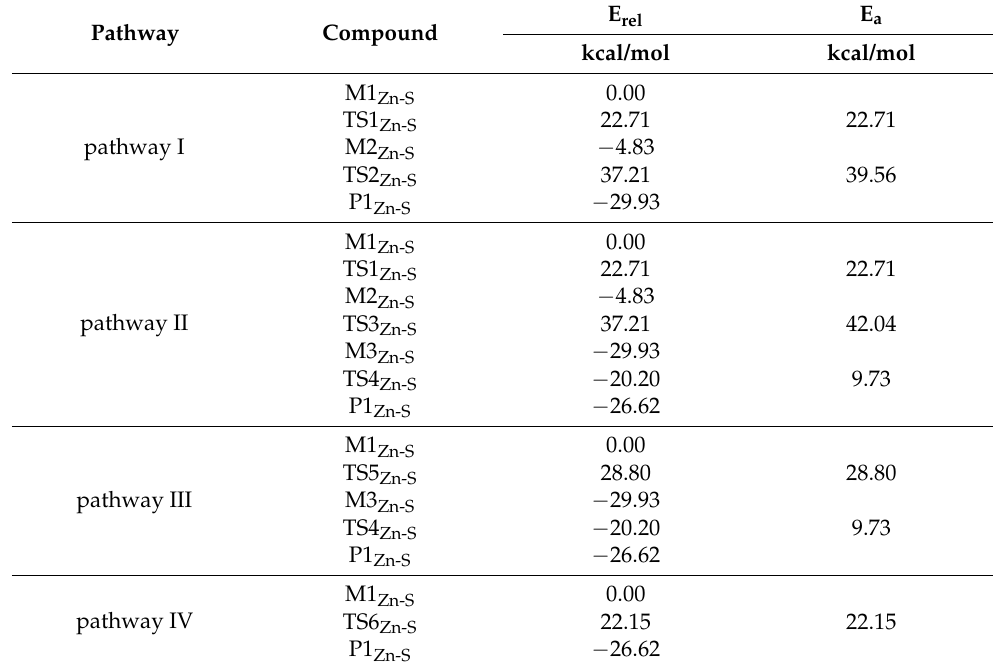
Table 2. The each position energies (E), relative energies (E rel ) and activation energies (E a ) of ammoborane reaction catalyzed by CoP Zn-S